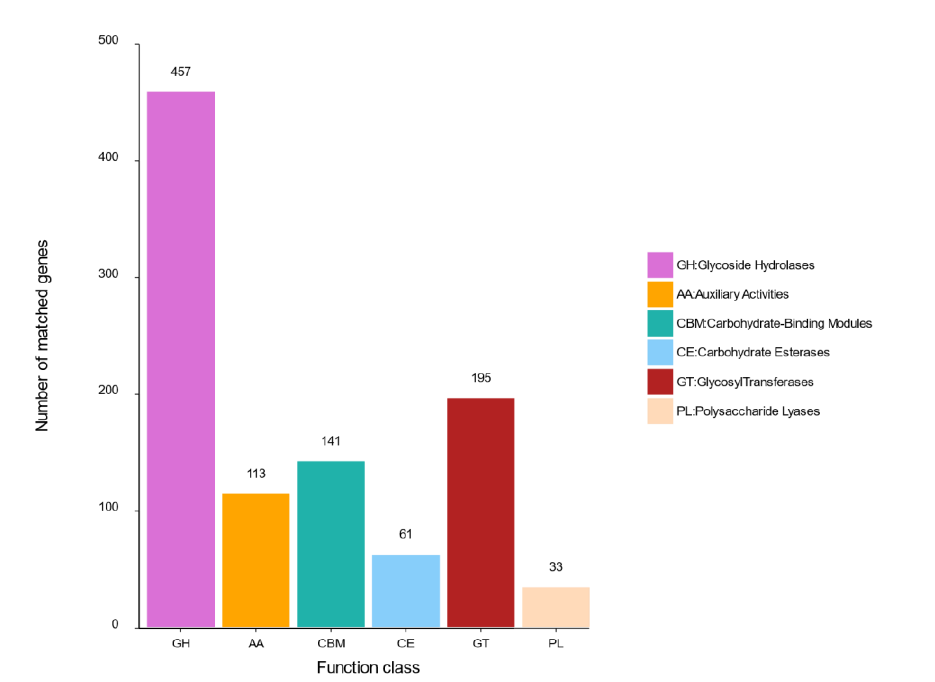
Figure 5. CAZy functional classification and the number of corresponding genes of strain R1.